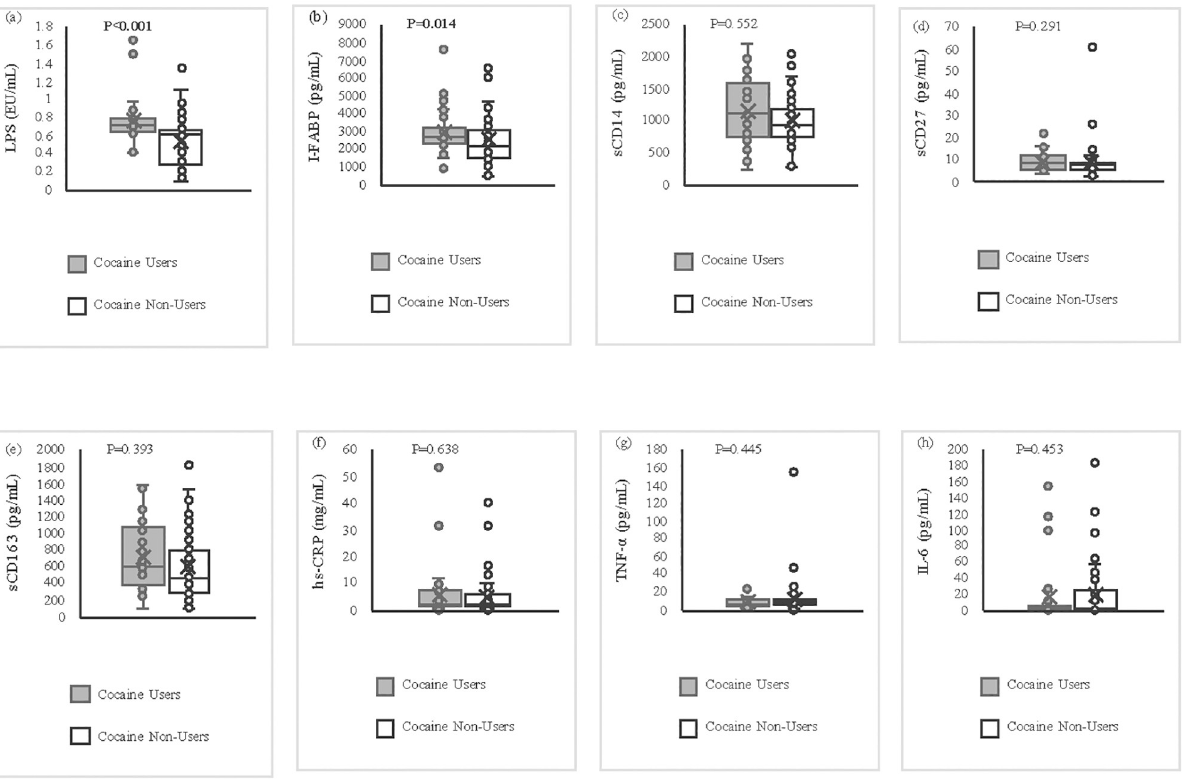
Fig 1. Comparison of gut permeability, microbial translocation, immune activation, and inflammatory markers between cocaine users and non- users. Bold indicates statistical significance at P < 0.05. Microbial translocation: a) LPS. Gut permeability: b) I-FABP. Immune activation: c) sCD14, d) sCD27, e) sCD163. Inflammation: f) hs-CRP, g) TNF- α , h) IL-6.